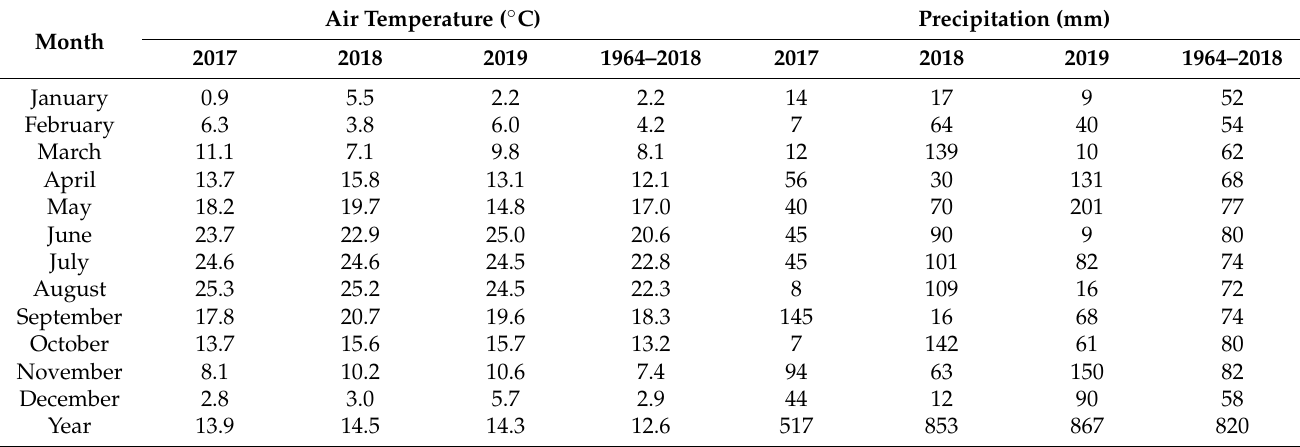
Table 1. Monthly mean air temperatures and monthly precipitations of the study period, and long-term averages (1964–2018) at the agricultural experimental farm of Padova University in Legnaro, northeastern Italy (45 ◦ 20 (cid:48) N, 11 ◦ 57 (cid:48) E). Air Temperature ( ◦ C) Precipitation Month